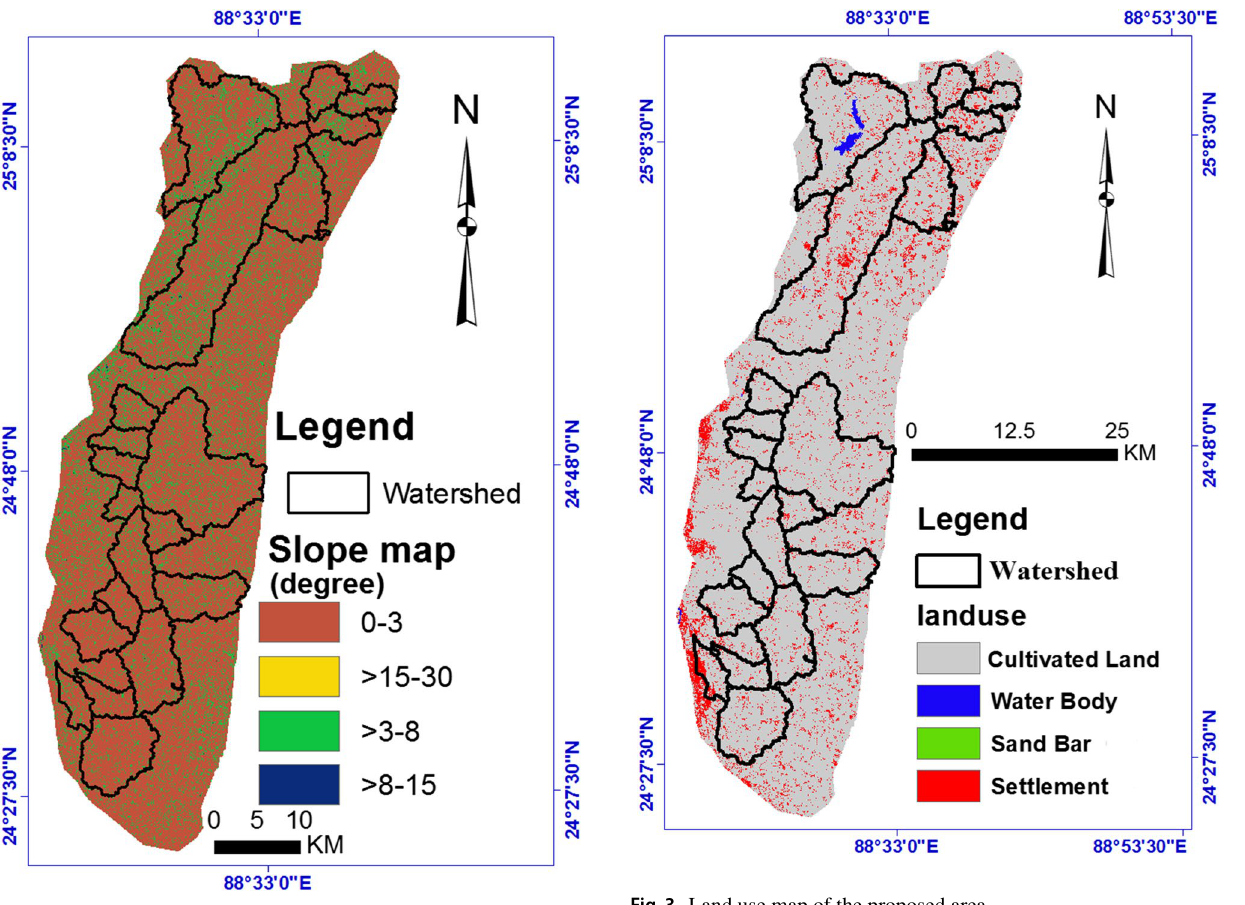
Fig. 2 Slope map of the proposed area